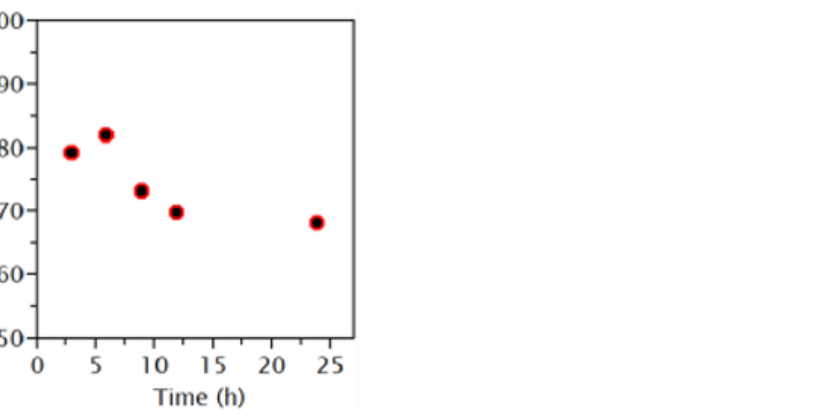
Figure 5. The relationship between inhibition efficiency and immersion time. Reprinted from [78].